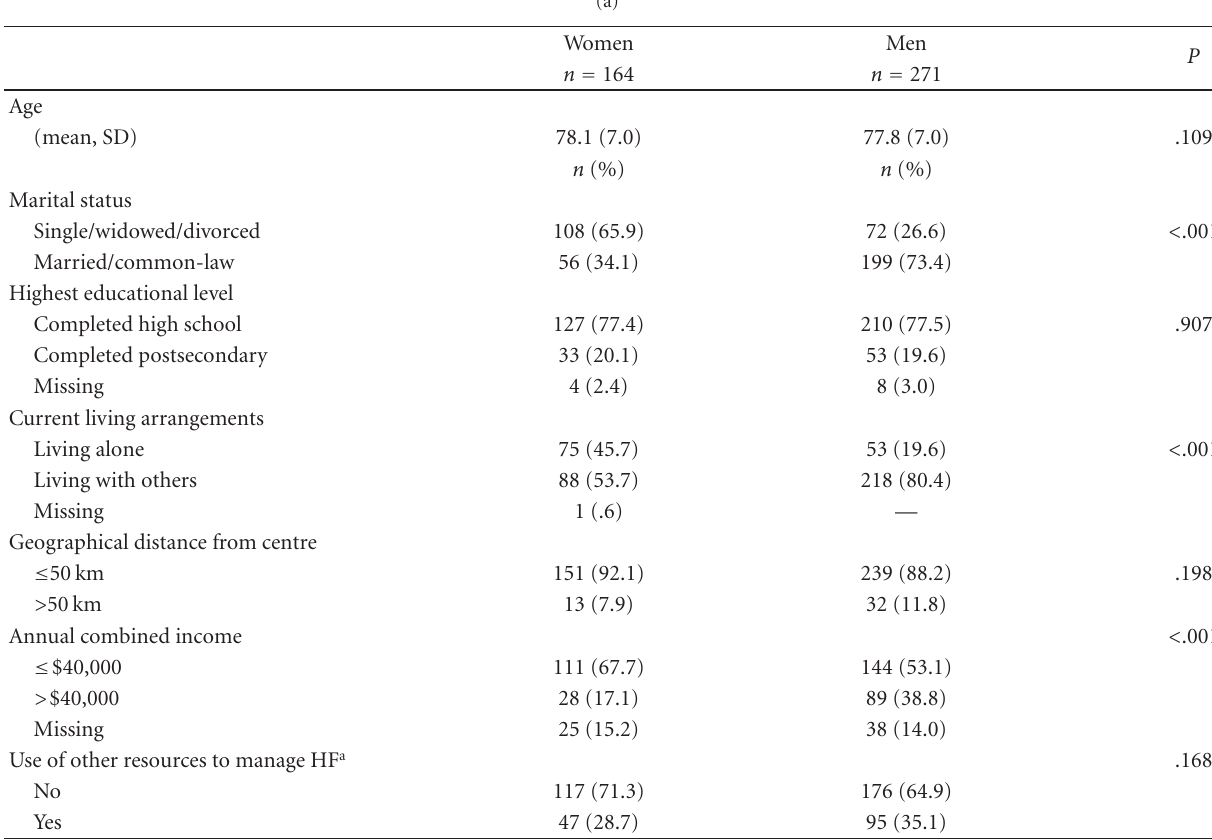
Table 2: (a) Baseline characteristics of participants (completers and noncompleters). (b) Clinical characteristics of participants (completers and